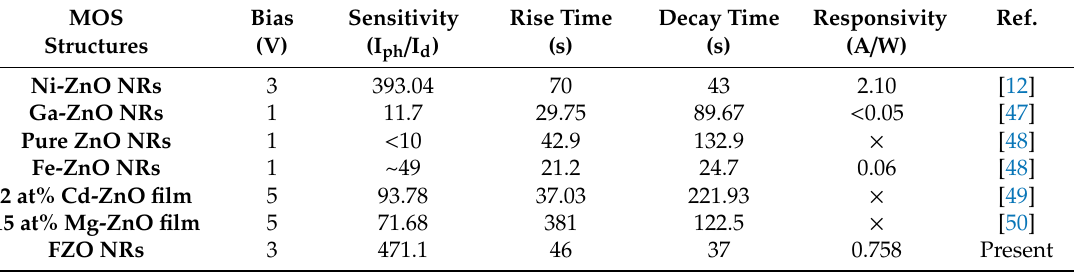
Figure 8. ( a ) Schematic diagram of FZO NR PDs under UV illumination. ( b ) The Schottky barrier formed at the interface between the FZO NRs and Ag electrodes, and the electron-hole pairs were photogenerated under UV light irradiation. Table 2. Comparison of the photosensitivity characteristics of FZO NRs and other reported MOS